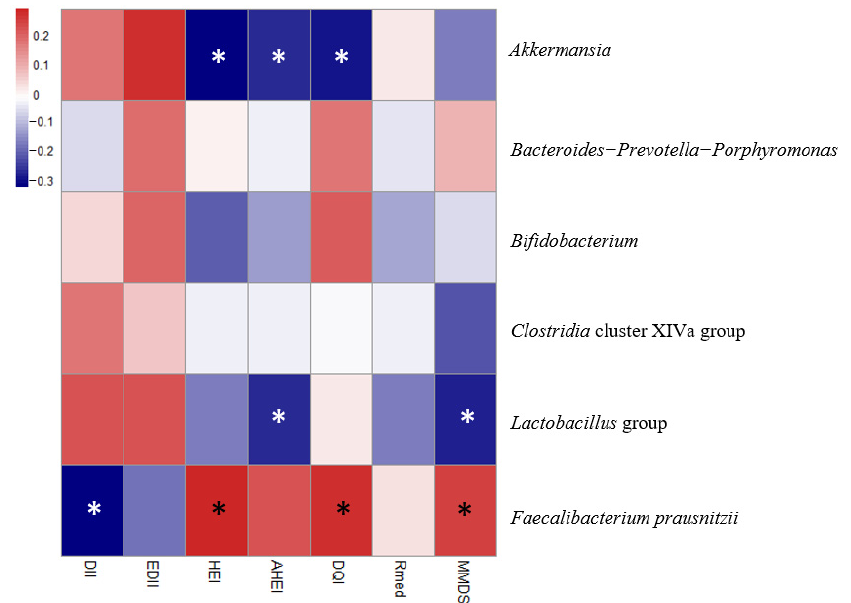
Figure 1. Heatmap defined by Pearson’s correlations between dietary indices scores and intestinal microbial groups. Blue and red colors represent negative and positive associations, respectively. The color intensity is proportional to the degree of association. Asterisks indicate correlation significance: * p ≤ 0.05. Table 3. Results obtained from regression analyses to identify dietary indices as predictors of gut microbiota levels (log 10 n°. cells per gram of feces), fecal short chain fatty acids (mM) and blood biomarkers.